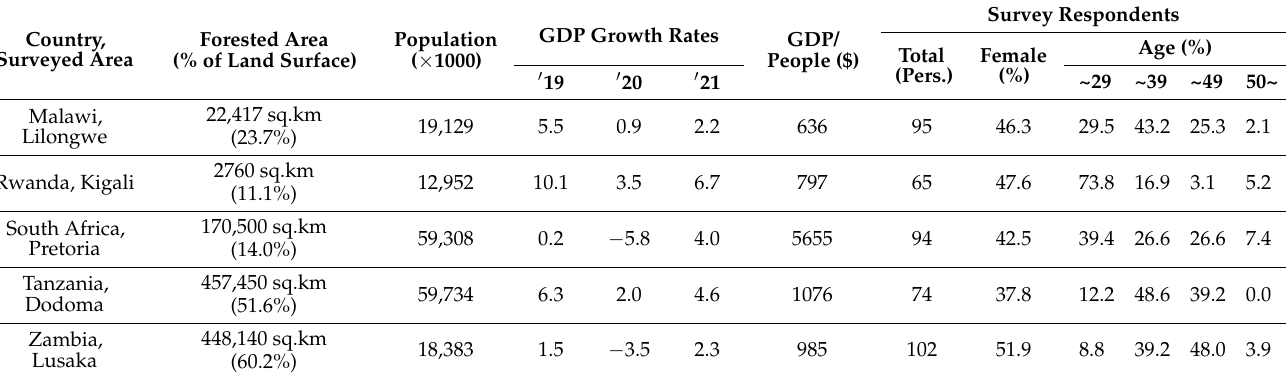
Table 1. Characteristics of participants and current status in each